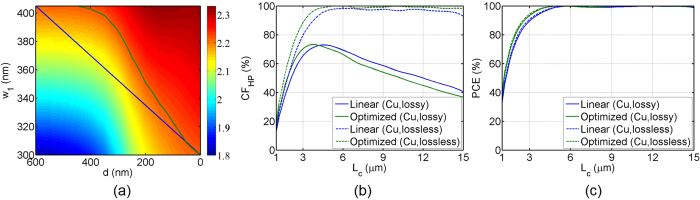
(a) Effective refractive index map of the fundamental modes (TE01, PRC0, or HP02), as functions of separation distance d and Si core width w1. Blue and green lines are the cases of linear and optimized (perfectly-phase-matched) taperings, respectively. Calculated (b) CFHP and (c) PCE as a function of Lc for linear (blue) and optimized (green) taperings. Thick and dashed lines are the lossy and lossless cases, respectively.